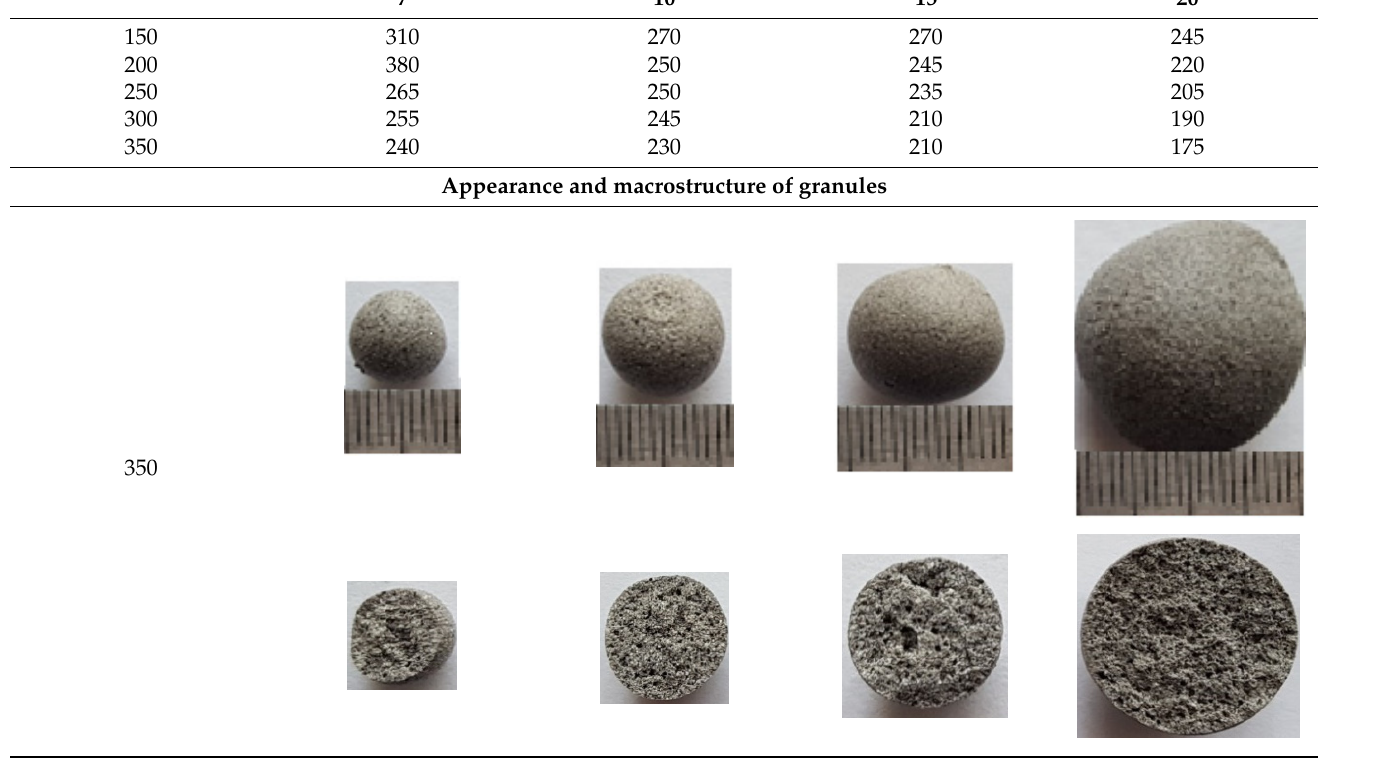
Table 6 . Effect of firing temperature on the properties of granules with a diameter of 10 mm .